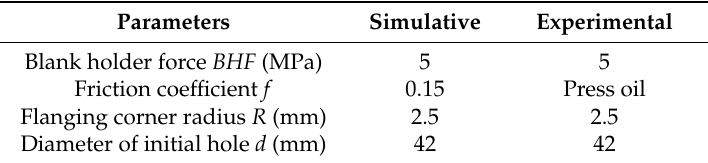
Table 3. Experiment and simulation conditions in reverse drawing–flanging combined process of B550CL spokes.